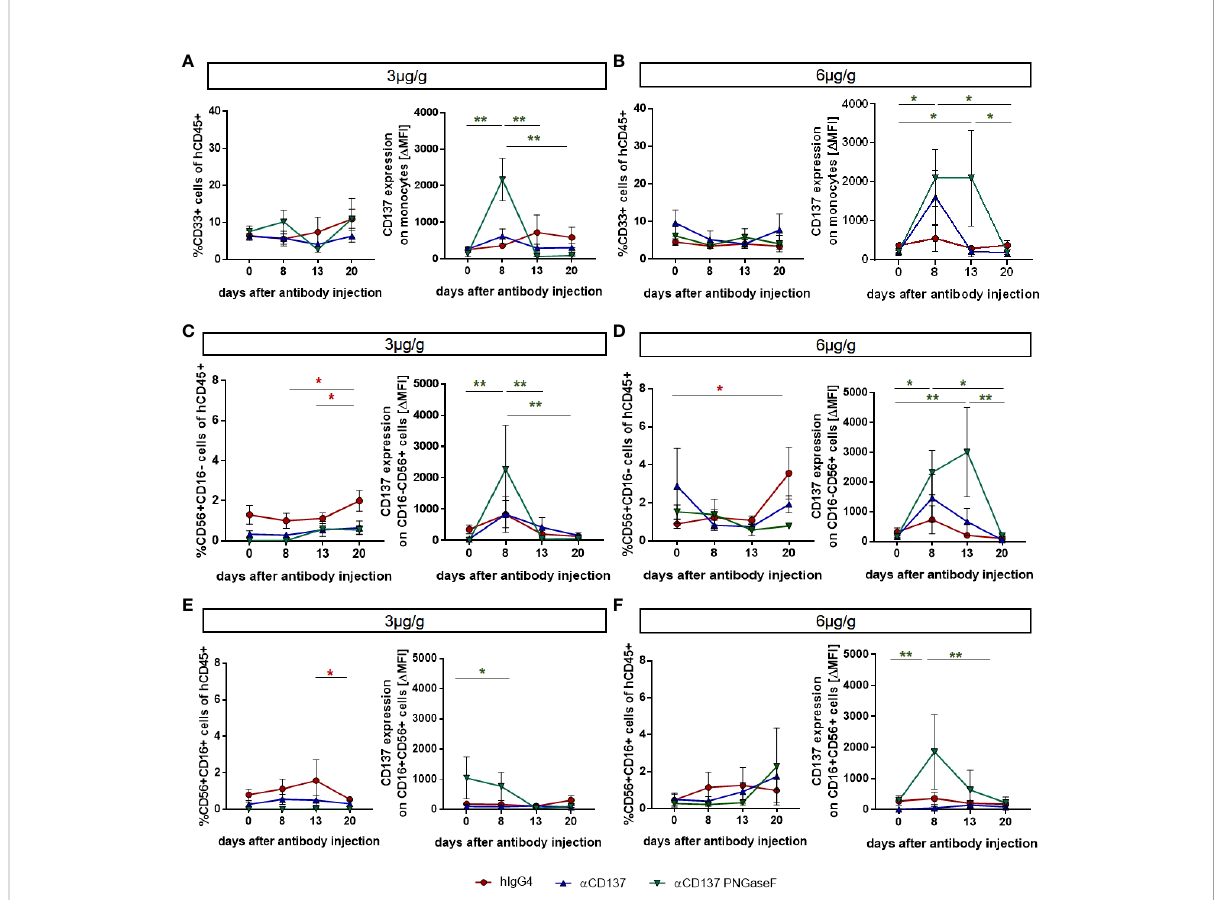
FIGURE 3 Effects of treatment with urelumab variants on human monocytes and NK cells in the peripheral blood of humanized mice. Humanized mice were injected with 3µg/g (hIgG4: n=3-4; a CD137: n=6; a CD137 PNGaseF: n=4) (A, C, E) or 6µg/g (hIgG4: n=7; a CD137: n=5; a CD137 PNGaseF: n=4) (B, D, F) of the human IgG4 isotype control, urelumab ( a CD137), or deglycosylated urelumab ( a CD137 PNGaseF) and studied for twenty days after antibody injection. (A, B) Shown are the relative changes in CD33+ monocyte numbers (left panel) as well as in CD137 expression (right panel, D MFI) on CD33+ monocytes at the indicated time-points after injection of 3 (A) or 6 (B) µg/g of the respective antibody preparations. (C-F) Shown are the relative changes in CD56 + CD16 - (C, D) and CD56 + CD16 + (E, F) NK cell subset abundance (left panel) as well as in CD137 expression (right panel) on the respective NK cell subsets at the indicated time-points after injection of 3 (C, E) or 6 (D, F) µg/g of the respective antibody preparations. Results are presented as mean +/-SEM. For statistical testing a 2-Way Anova with Tukey ’ s multiple comparison test was used. *p<0.05;